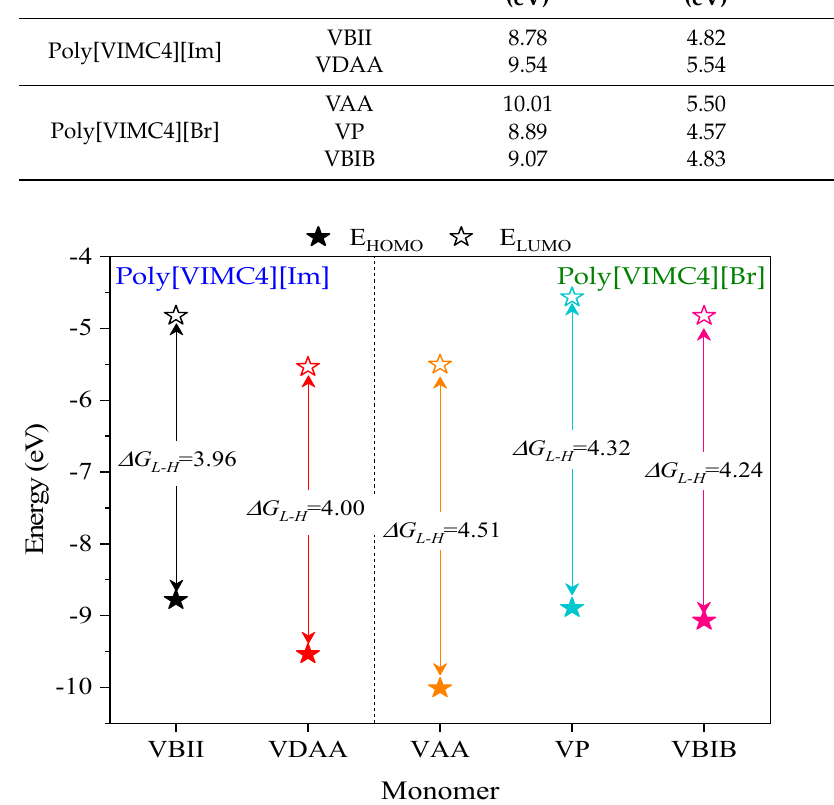
Figure 15. Representation of HOMO and LUMO energy levels and ∆ G L-H for the different monomers of their optimized geometries in water at B3LYP/6-311++.